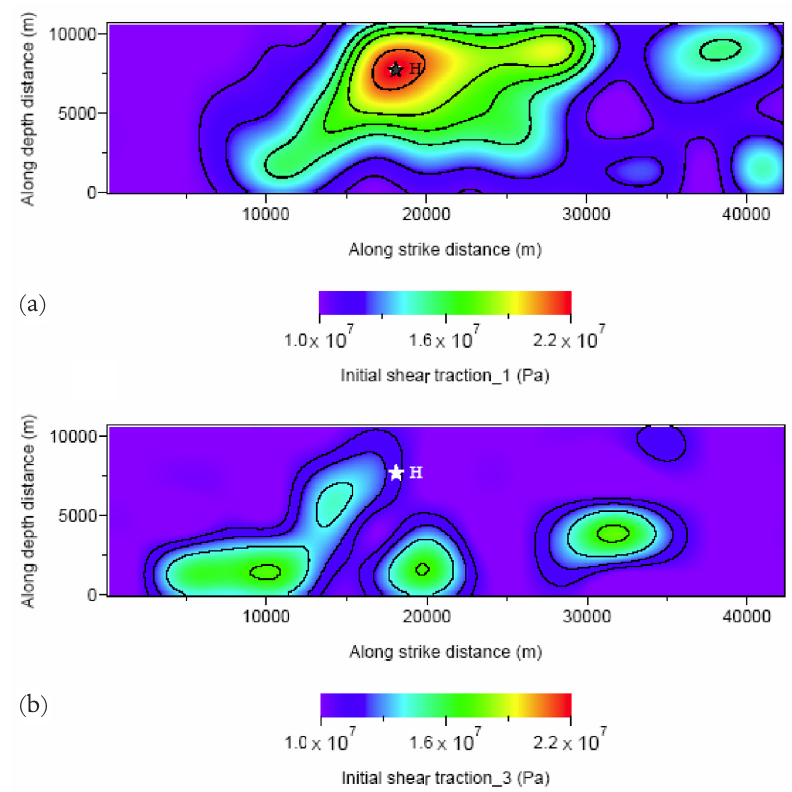
Figure 8. Spatial distribution of the initial shear stress adopted in Model C. (a) Along strike component. (b) Along depth